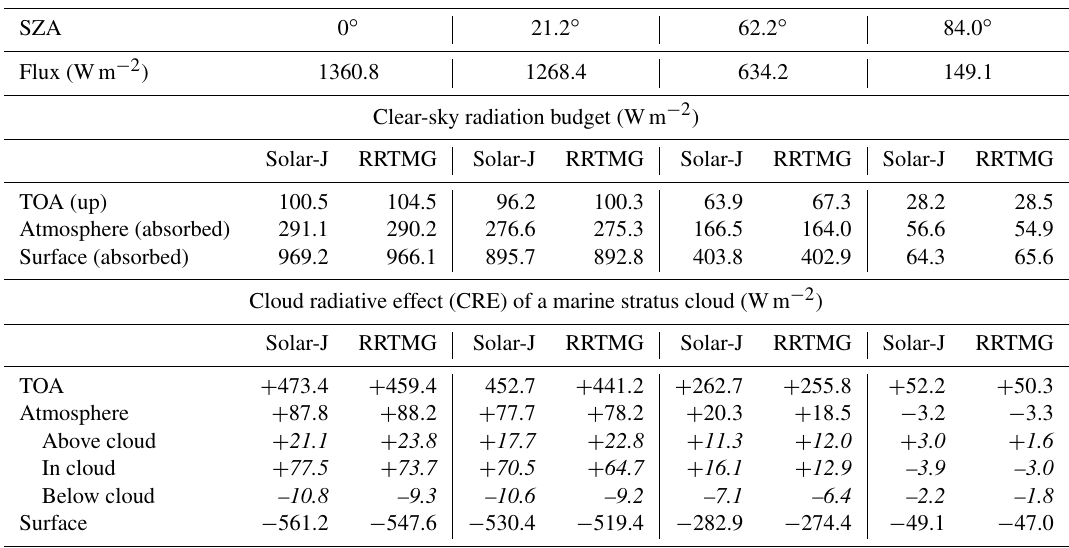
Table 5. Radiation budget comparison (Wm − 2 ) between Solar-J and RRTMG-SW for top of atmosphere (TOA), atmosphere, and surface across four SZAs. Also shown is the cloud radiative effect (CRE) of a typical marine stratus cloud, for which the atmospheric absorption is split into above cloud, in cloud, and below cloud, and the values are shown in italics.